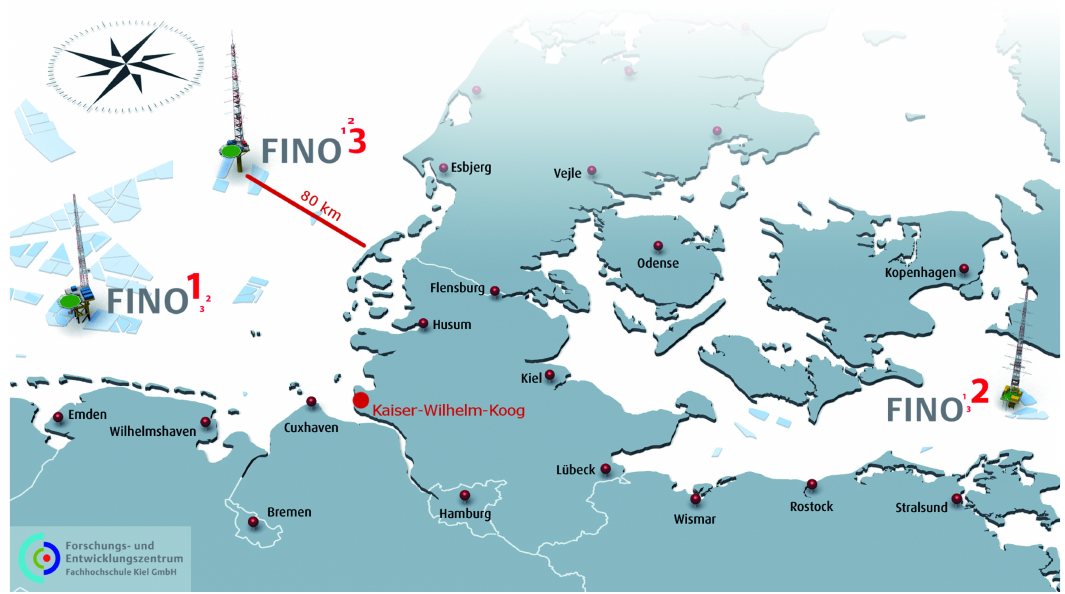
Figure 2. Locations of onshore (Kaiser–Wilhelm–Koog) and offshore (FINO3 platform) test sites, 80 km west of the island of Sylt. c (cid:13) FEZ FH Kiel GmbH, Graphics: Bastian Barton.